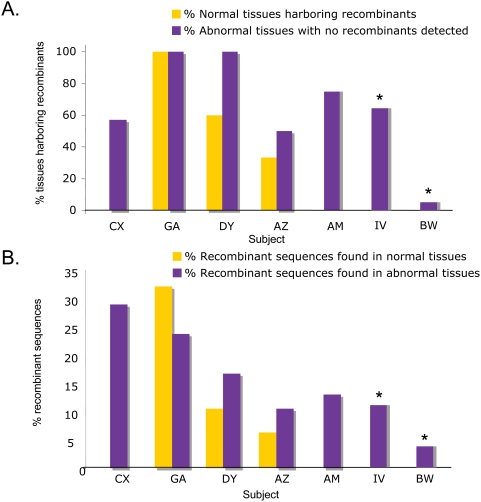
Frequency of recombination.In panel A the graph shows for each subject (x-axis), the percentage of tissues harboring recombinants (y-axis). In panel B the graph shows the percent of recombinant sequences found in normal and abnormal tissues for each subject. Tissues with normal and abnormal histopathology are indicated in yellow and purple respectively. * Only tissues with abnormal histopathology were collected from patient IV and BW.